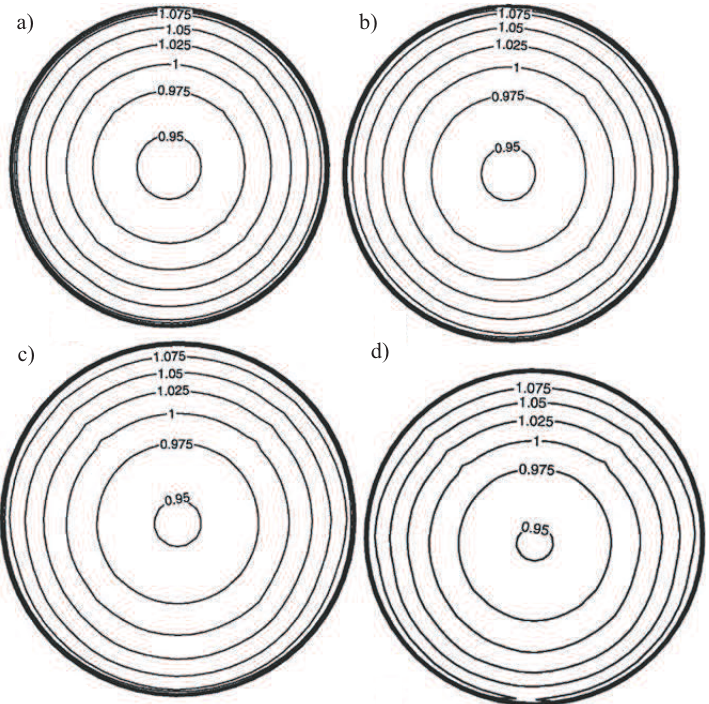
Figure 10. Contours of Mach number in nozzle throat for cylindrical channel for α = 0 ◦ ( a ), 3 ◦ ( b ), 6 ◦ ( c ), 9 ◦ ( d